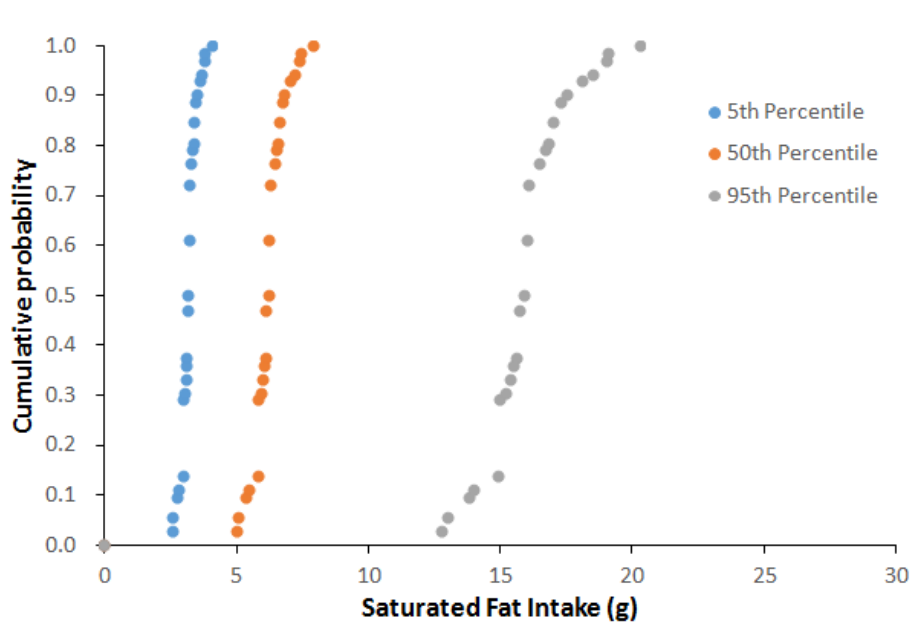
Figure 4. Cumulative probability of salt (g) intake per capita and per day of Greek adults’ consuming feta cheese marketed in the Greek market for the fifth, 50th and 95th percentiles of daily consumption. Nutrient intake was expressed as percentage of the European daily reference intake (DRI) values as set by the European Regulation (EU) 1169/2011 on the provision of food information to consumers, in order to demonstrate the contribution of feta cheese consumption to a healthy adult’s diet. Figures 5 and 6 present the box plots of the daily nutrient intake as DRI percentage by feta cheese consumption for the 50th and 95th percentiles of daily consumption quantity. For the 50th percentile of daily feta consumption (corresponding to 39 g), the estimated ranges for energy, total fat, saturated fat carbohydrates, sugars, proteins and salt were 4.3–6.7%, 11.1–16.2%, 25–39.6%, 0–0.5%, 0–1.3%,